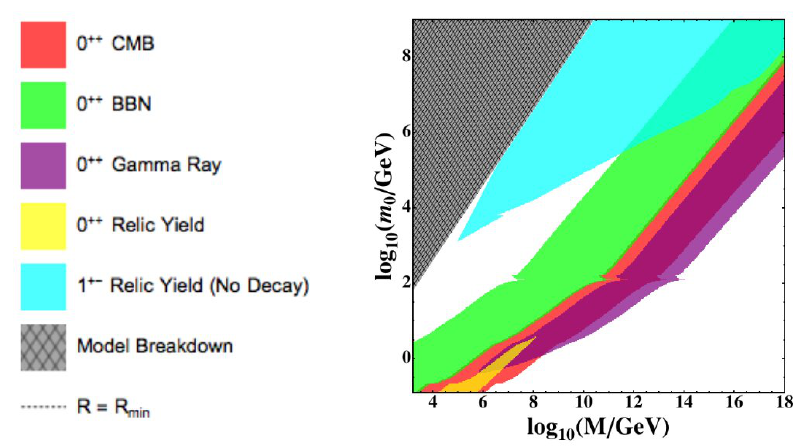
Figure 13: Example of constraints on 0 ++ and 1 + − glueballs from CMB, BBN and relic density, assuming a minimal value of the entropy ratio R = s (cid:48) / s such that T (cid:48) ∼ Λ (cid:48) , conserved dark C -parity, and absence of dimension-6 operators in Eq. (38), from > M / 10, and the effective field Ref. [ 81 ] . “Model Breakdown” indicates where m 0 theory treatment of the portal interaction may not be